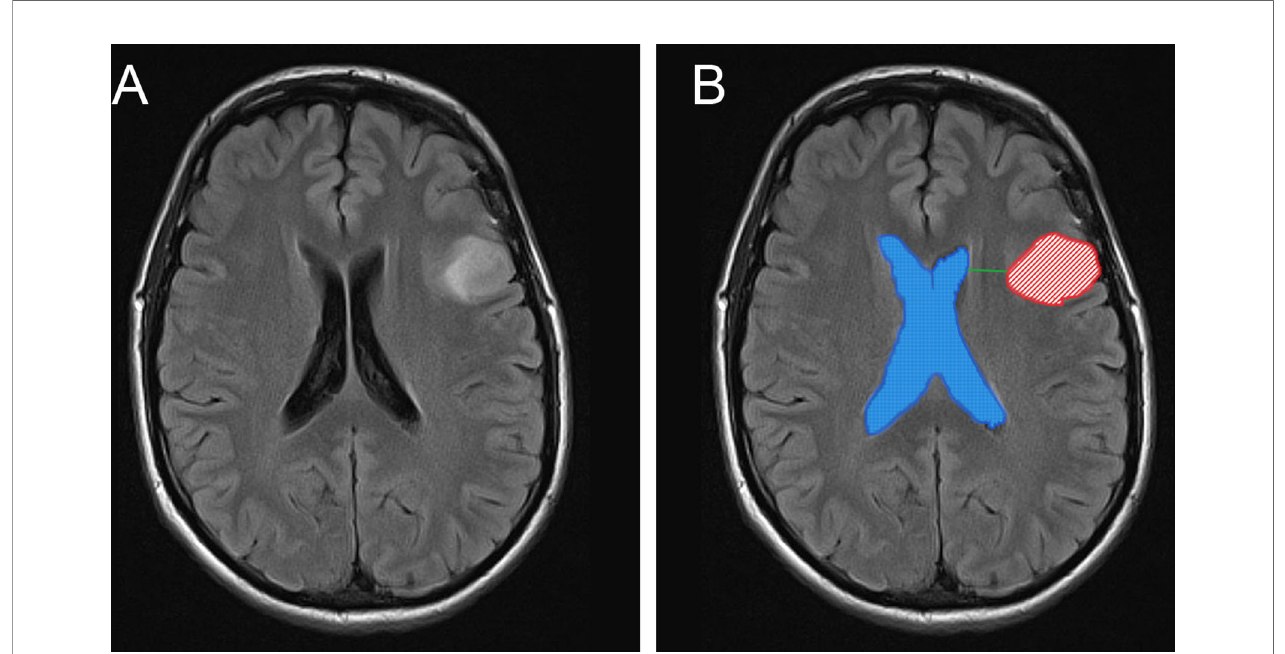
FIGURE 1 | MR images depicts the anatomical position between tumors and the SVZ, calculation methods of V G and V GW . Representative MR image of tumor without SVZ involvement (A) . The tumor lesions and ventricles are manually segmented and shown as red and blue masks. The shortest distance between the tumor edge and the lateral ventricles was showed as green line (B)